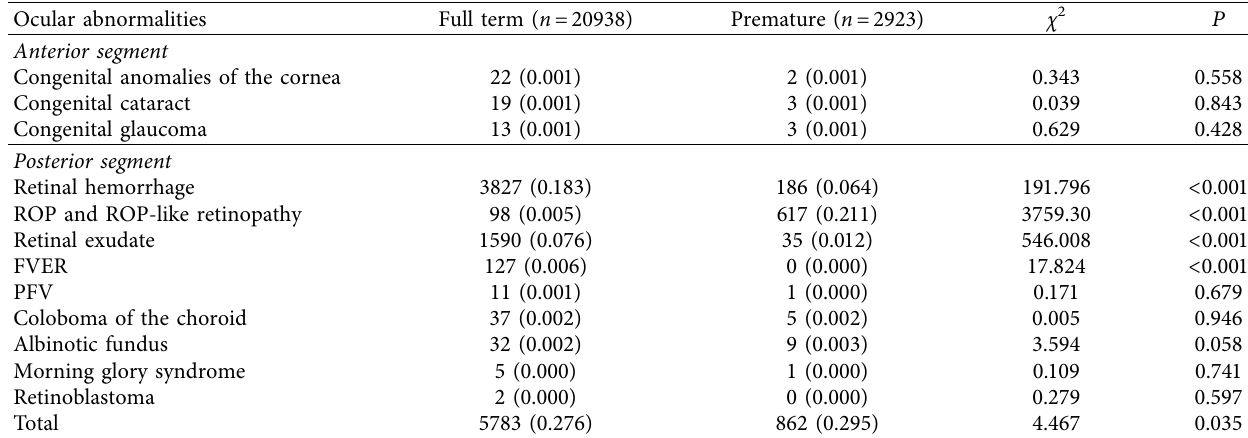
Figure 1: Rare ocular abnormalities were found in neonates through digital imaging. (a) Familiar exudative vitreoretinopathy. (b) Persistent fetal vasculature. (c) Albinotic fundus. (d) Morning glory syndrome. (e) Coloboma of the choroid. (f) Retinoblastoma. Table 2: Ocular abnormalities of newborns in Ningbo.